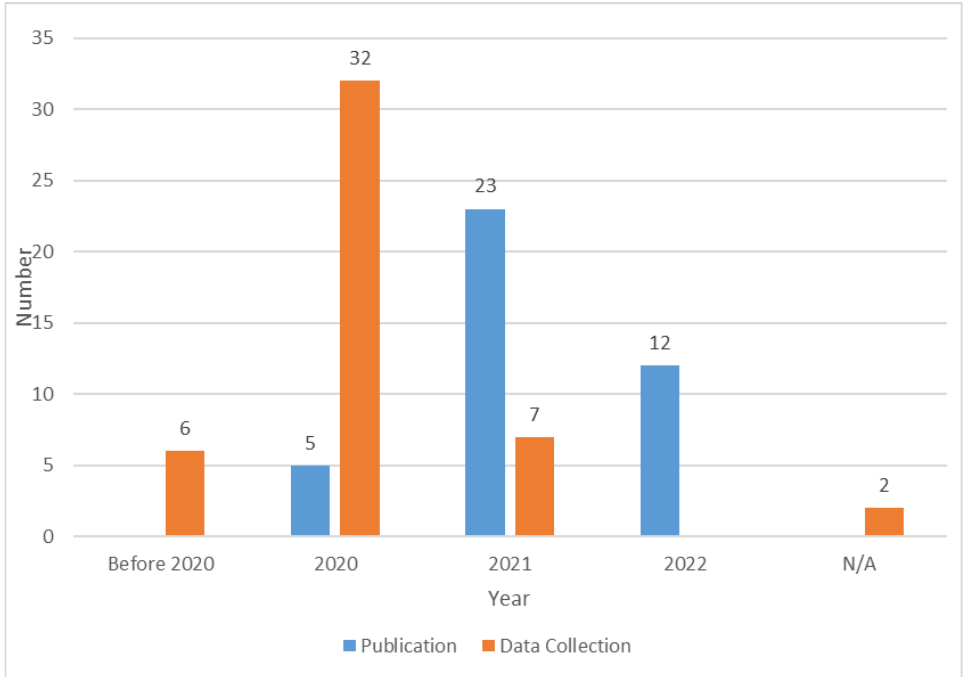
Figure 2. The year of publication and data collection.